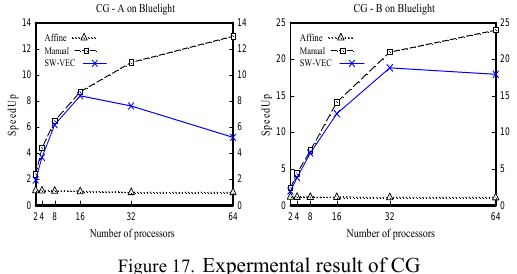
Figure 17. Expermental result of CG